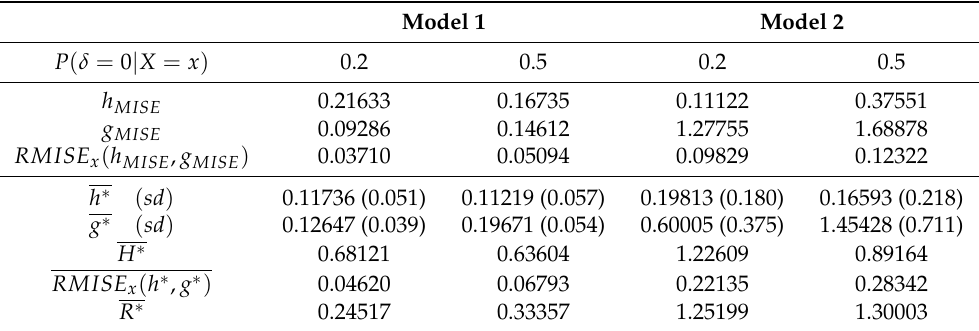
Table 2. MISE, average bootstrap bandwidths and estimation errors of the smoothed Beran’s PD estimator in each level of censoring conditional probability for Models 1 and 2. Numbers within brackets are standard